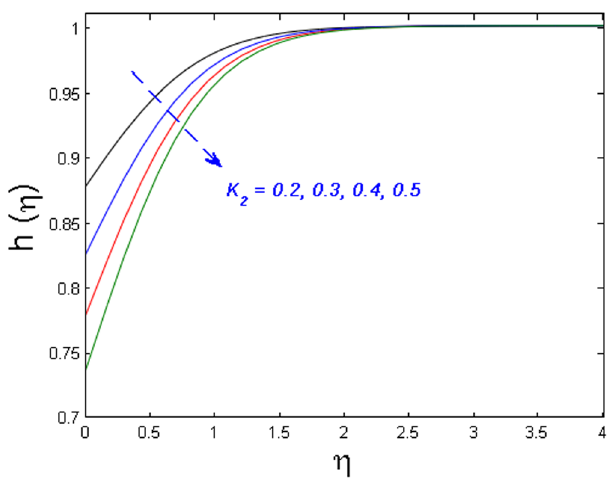
Figure 22. Effect of of K 2 on h ( η ).